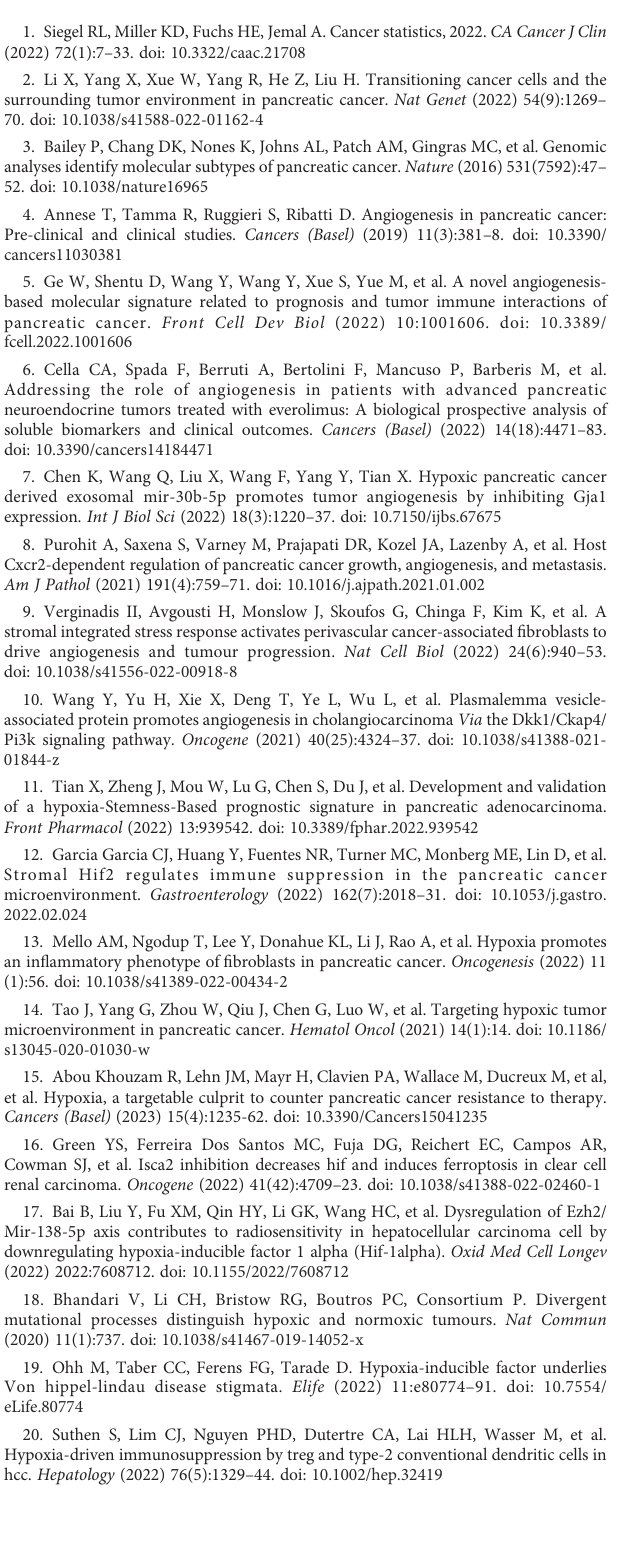
SUPPLEMENTARY TABLE 6 Results of GO enrichment analysis. SUPPLEMENTARY TABLE 7 Results of KEGG enrichment